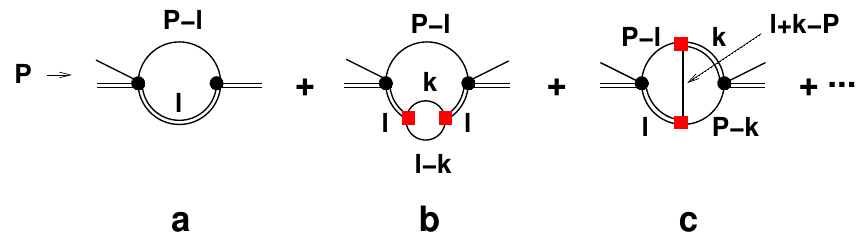
Figure 9 . The lowest-order diagrams, contributing to the shaded blob in the particle-dimer picture, see (cid:12)gure 8b. The double line depicts a dimer and the single line | a